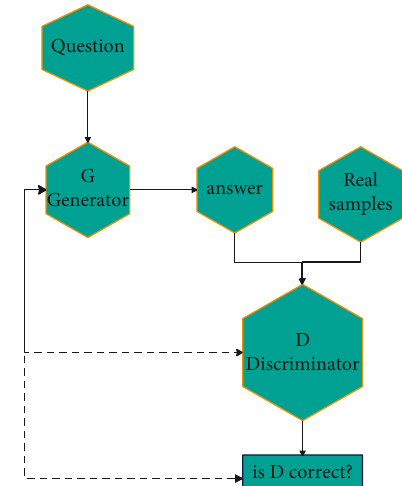
Figure 1: Generative confrontation network structure of dialogue generation